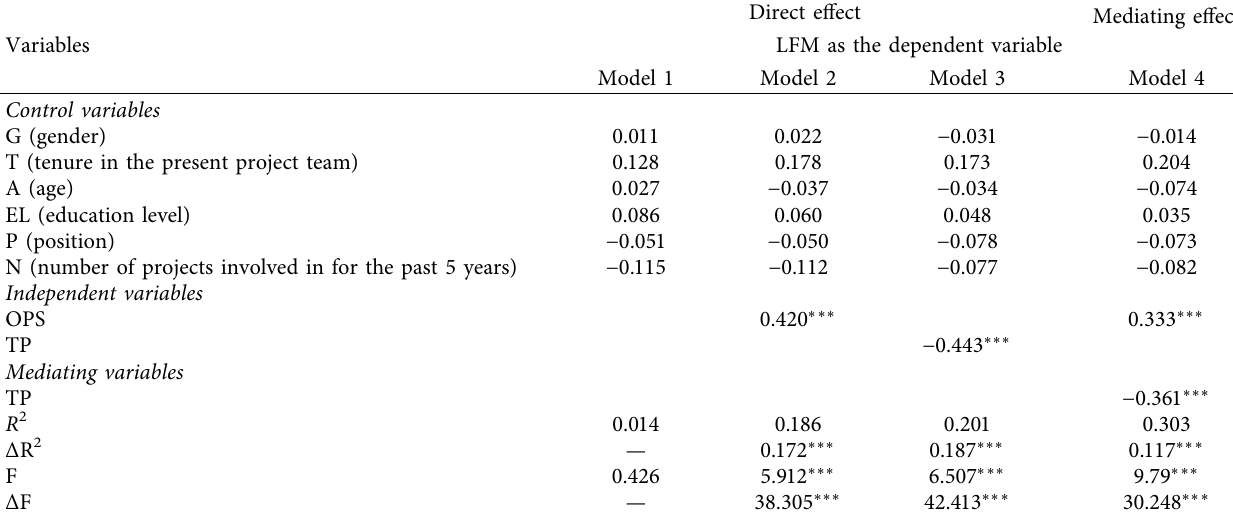
Table 4: Parameter estimates of the performed multilevel linear